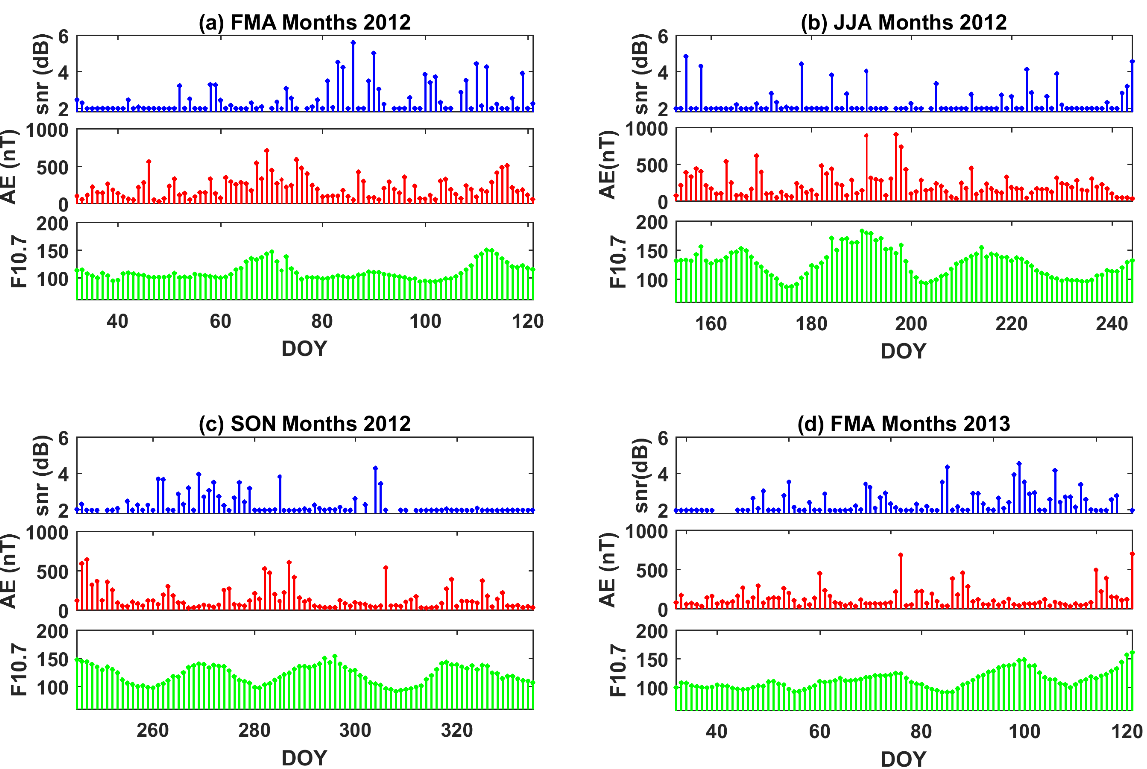
Figure 6. Day-of-year variation in nocturnal average SNR at 300 km, daily averaged AE and F10.7 during ( a ) FMA 2012, ( b ) JJA 2012, ( c ) SON 2012, and ( d ) FMA 2013. Top, middle, and bottom sub-panels in each of these show SNR, AE, and F10.7, respectively.